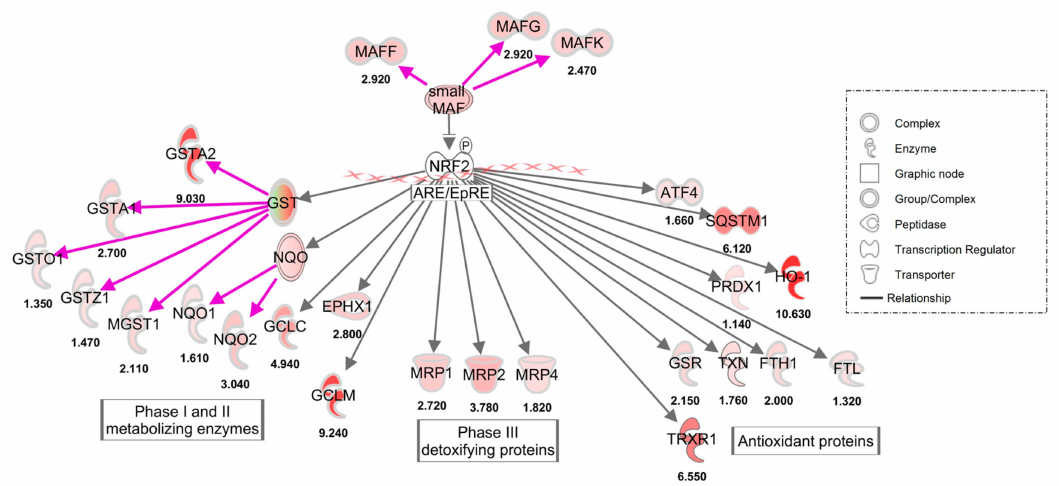
Figure 2. Ingenuity Pathway Analysis (IPA) indicates that PB125 activates the Nrf2 transcription factor